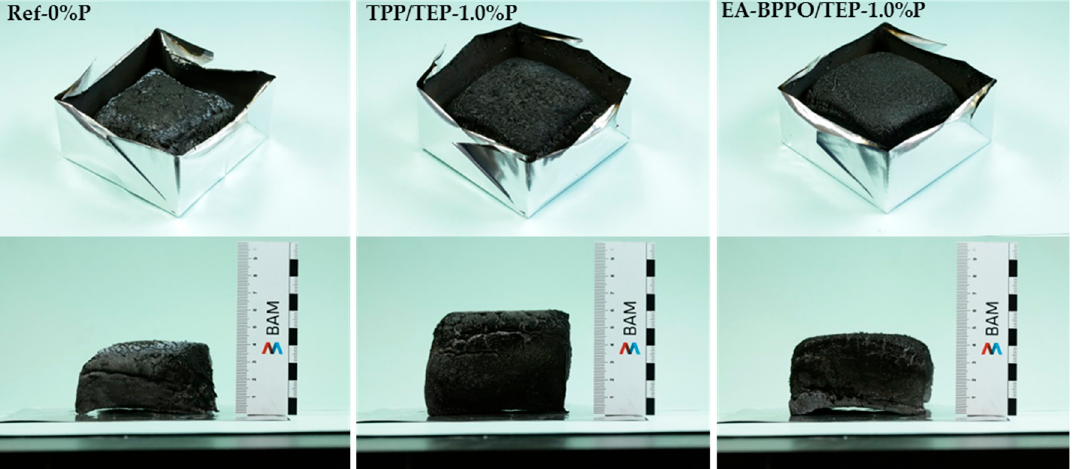
Figure 7. Images of foam Ref-0%P, TPP/TEP-1.0%P, and EA-BPPO/TEP-1.0%P after the cone calorimeter test.